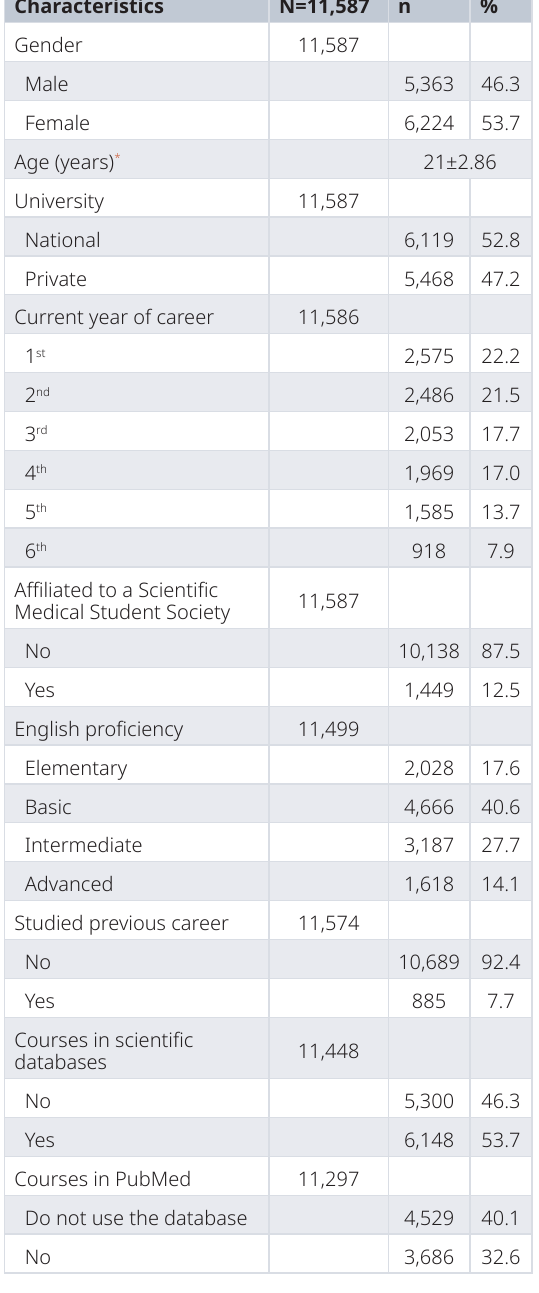
Table 1. Characteristics of medical students from 40 schools of medicine in Latin